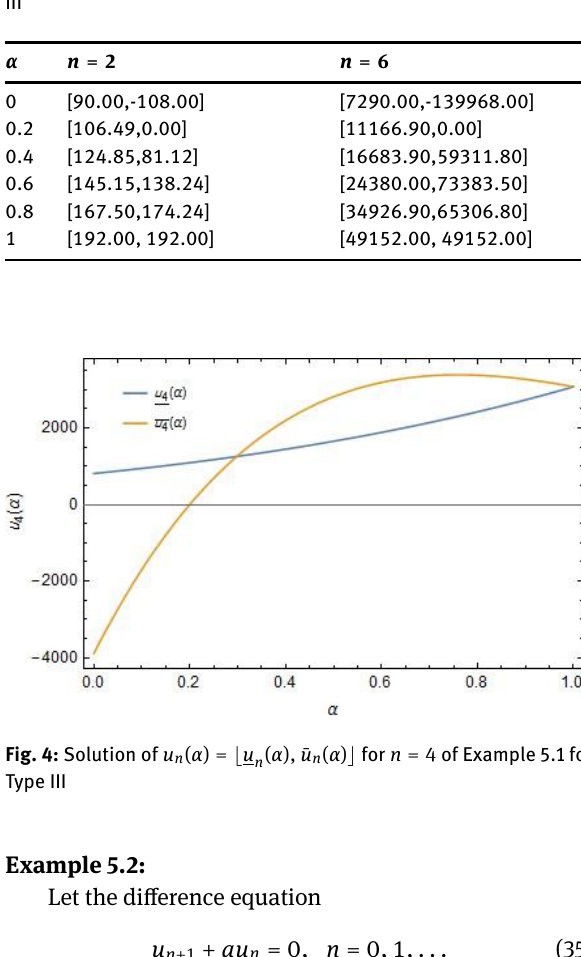
Fig. 3: Solution of u n ( α ) = ⌊ u n ( α ), ¯ u n ( α ) ⌋ for n = 4 of Example 5.1 for Type II